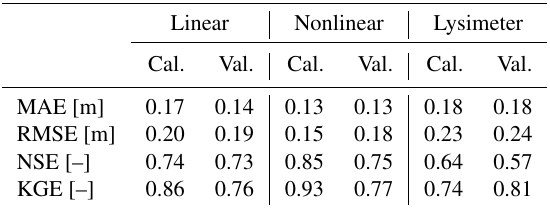
Table 2. Performance metrics for the similarity between the esti- Table 1. Goodness-of-fit metrics for the groundwater-level simu- mated recharge and the measured recharge, in millimeters per 10d. lation for each model. The metrics are computed for the calibra- tion period (2007–2016) and the validation period (2017–2019). The metrics are shown for the calibration period (2007–2016) and Groundwater-level measurements with a 10d time interval were the validation period (2017–2019). used to calculate these metrics, similar to the measurements used for calibration. Linear Linear Nonlinear Lysimeter